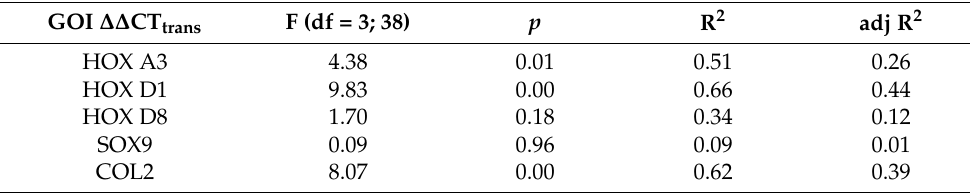
Table 5. F-values for MLR with degrees of freedom (df), significance levels ( p ) and quality of the MLR model for each GOI without (R 2 ) and with correction (adjusted R 2 ) for the parameters location, cultivation time and ID .